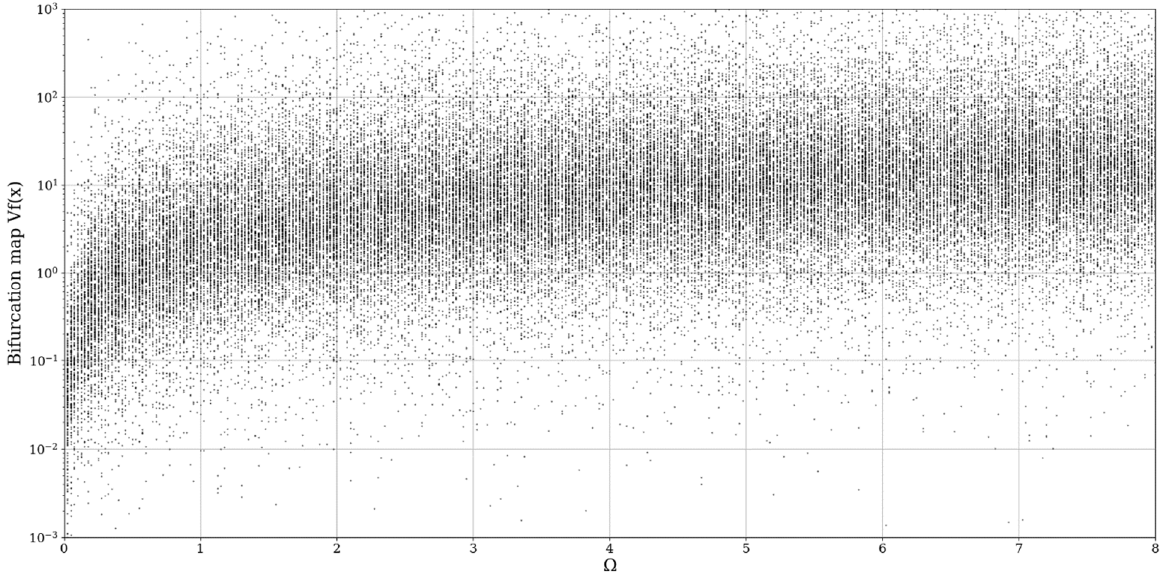
Figure 2. Bifurcation map of atmospheric multifractal non-differentiable velocity V F ( x,t ) ; control parameter: Ω .